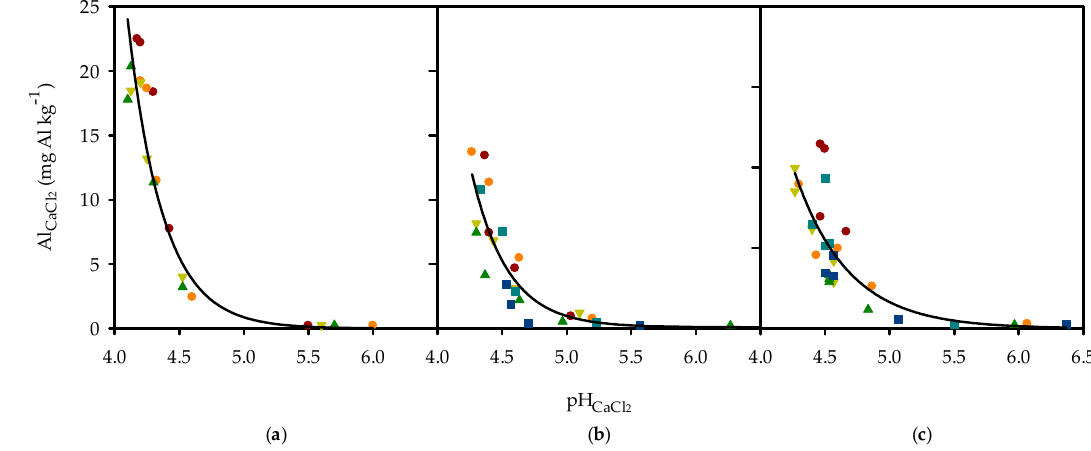
Figure 3. ( a ) Relationship between pH CaCl 2 and Al CaCl 2 (mg Al kg − 1 ) across sampling depths for the ST (Al CaCl 2 = (85,221,378 × exp( − 3.67 × pH CaCl 2 ), r 2 = 0.94; ( b ) MT (Al CaCl 2 = 0.09 + (47,860,313 × exp( − 3.56 × pH CaCl 2 ), r 2 = 0.78); and ( c ) LT (Al CaCl 2 = 0.001 + (292,525 × exp( − 2.41 × pH CaCl 2 ), r 2 = 0.60 experiments for the various L and G treatments measured in March 2018. The ST, MT, and LT; L and G treatments are C ( • ), L2.5 ( (cid:72) ), G2.5 ( (cid:78) ), and L2.5 + G2.5 ( (cid:7) ). The additional treatments in the MT are; L5.0 ( (cid:4) ) and L5.0 + G2.5 ( (cid:4) ); and in the LT are L2 ( (cid:4) ) and L8 ( (cid:4) ).